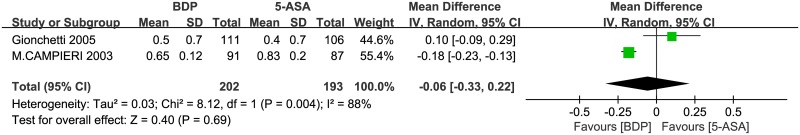
Forest plot of randomized controlled trials of BDP vs. 5-ASA in inducing Reduction of DAI parameters: stool frequency, in ulcerative colitis.BDP, beclomethasone dipropionate. 5-ASA, mesalazine. M-H, Mantel-Haenszel.